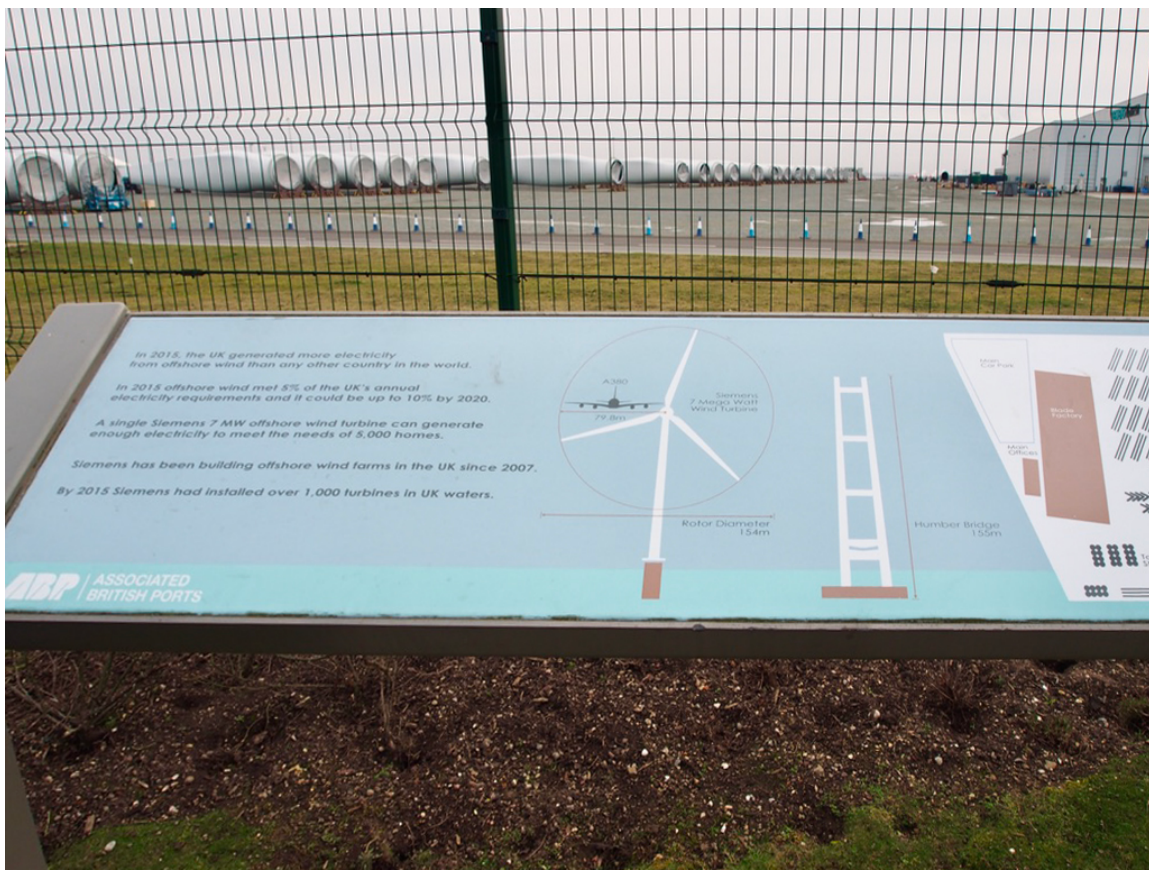
Information board on renewable energy, original photo by author, 2020.